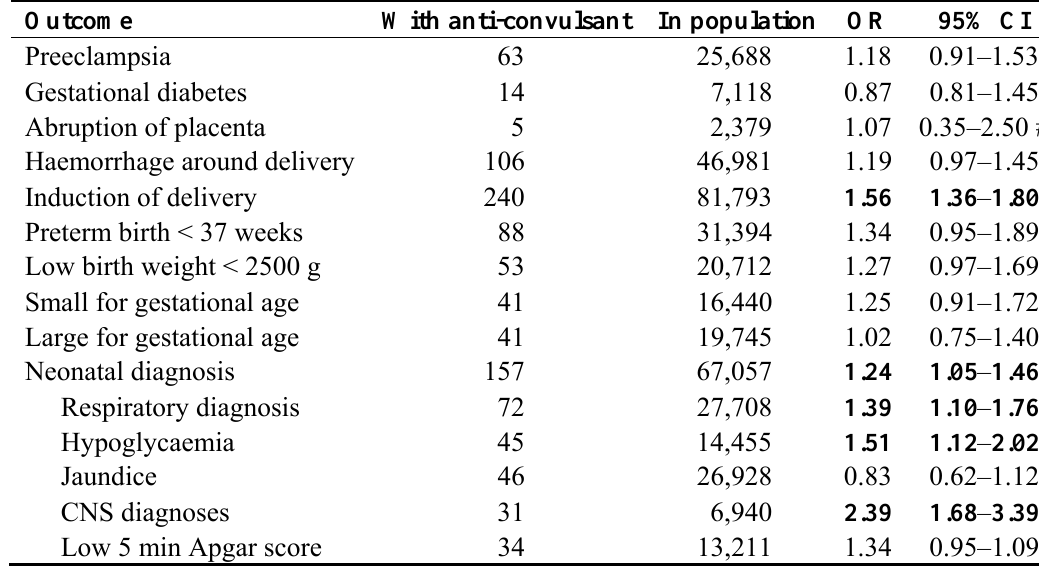
Table 15. Outcomes after maternal use of anticonvulsants during the 2nd or 3rd trimester. Bold text marks statistical